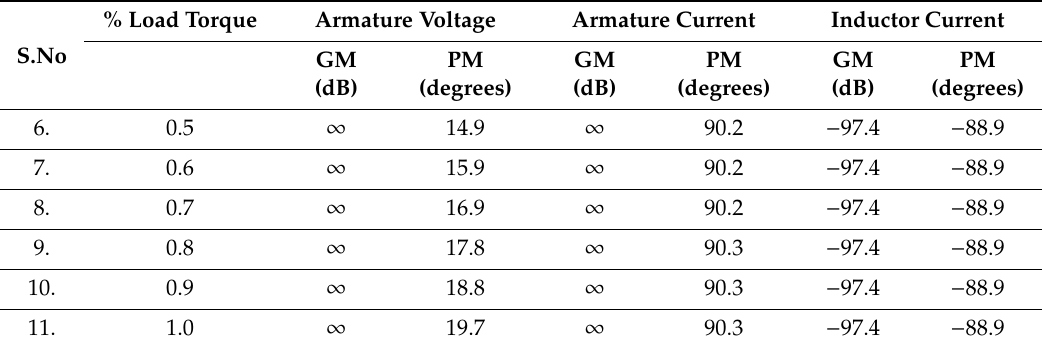
Figure 5. Hardware setup for buck converter-fed DC motor. Specifications of interest are shown in Table 1. Experiments were conducted for various load torque and various speed references (Figure 6). For PIC, K p and K i values are obtained using the Ziegler–Nichols method. Simulation and experimentation study were completed, and the following observations are made from the results, which are shown in Figures 5 and 6: